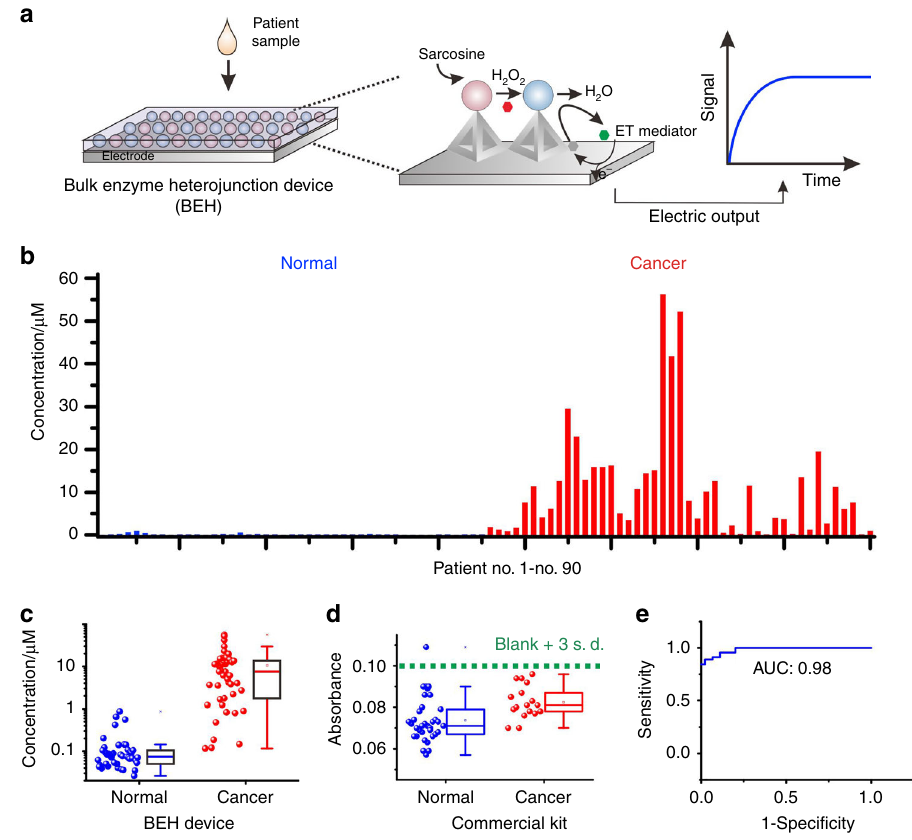
Fig. 5 Sarcosine detection in clinical samples. a Schematics for the BEH-based sarcosine sensor. b Sarcosine detection with a multiplexed electrochemical chip in 90 clinical samples including serum from normal people (45 cases) and cancer patients (45 cases). c Statistical analysis reveals effective discrimination of cancer patients from normal people using the sarcosine sensor. d A control sarcosine assay with the commercial kit in clinical samples. Of note, most signals were in distinguishable from the background due to the poor sensitivity. e ROC analysis for the discrimination between normal and PCa using the sarcosine sensor. In the boxplots of c and d the horizontal line represent the median value, the up and down bounds of box represent the fi rst quartile and third quartile values and the vertical lines represent the whisker. The sample size used to derive statistics is 45 for each group in c . The sample size used to derive statistics is 35 and 17 for groups in d . Source data are provided as a Source Data fi